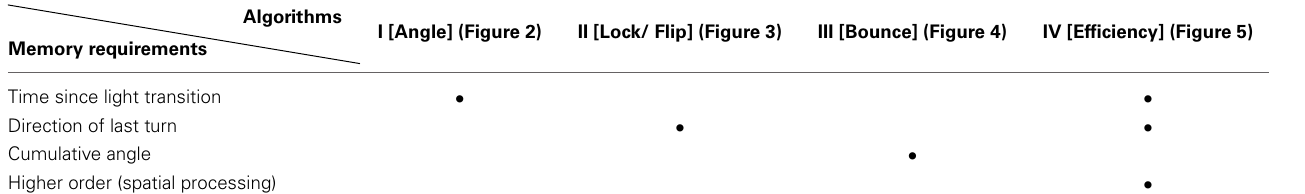
Table 1 | Summary of behavioral Algorithms and the corresponding memory